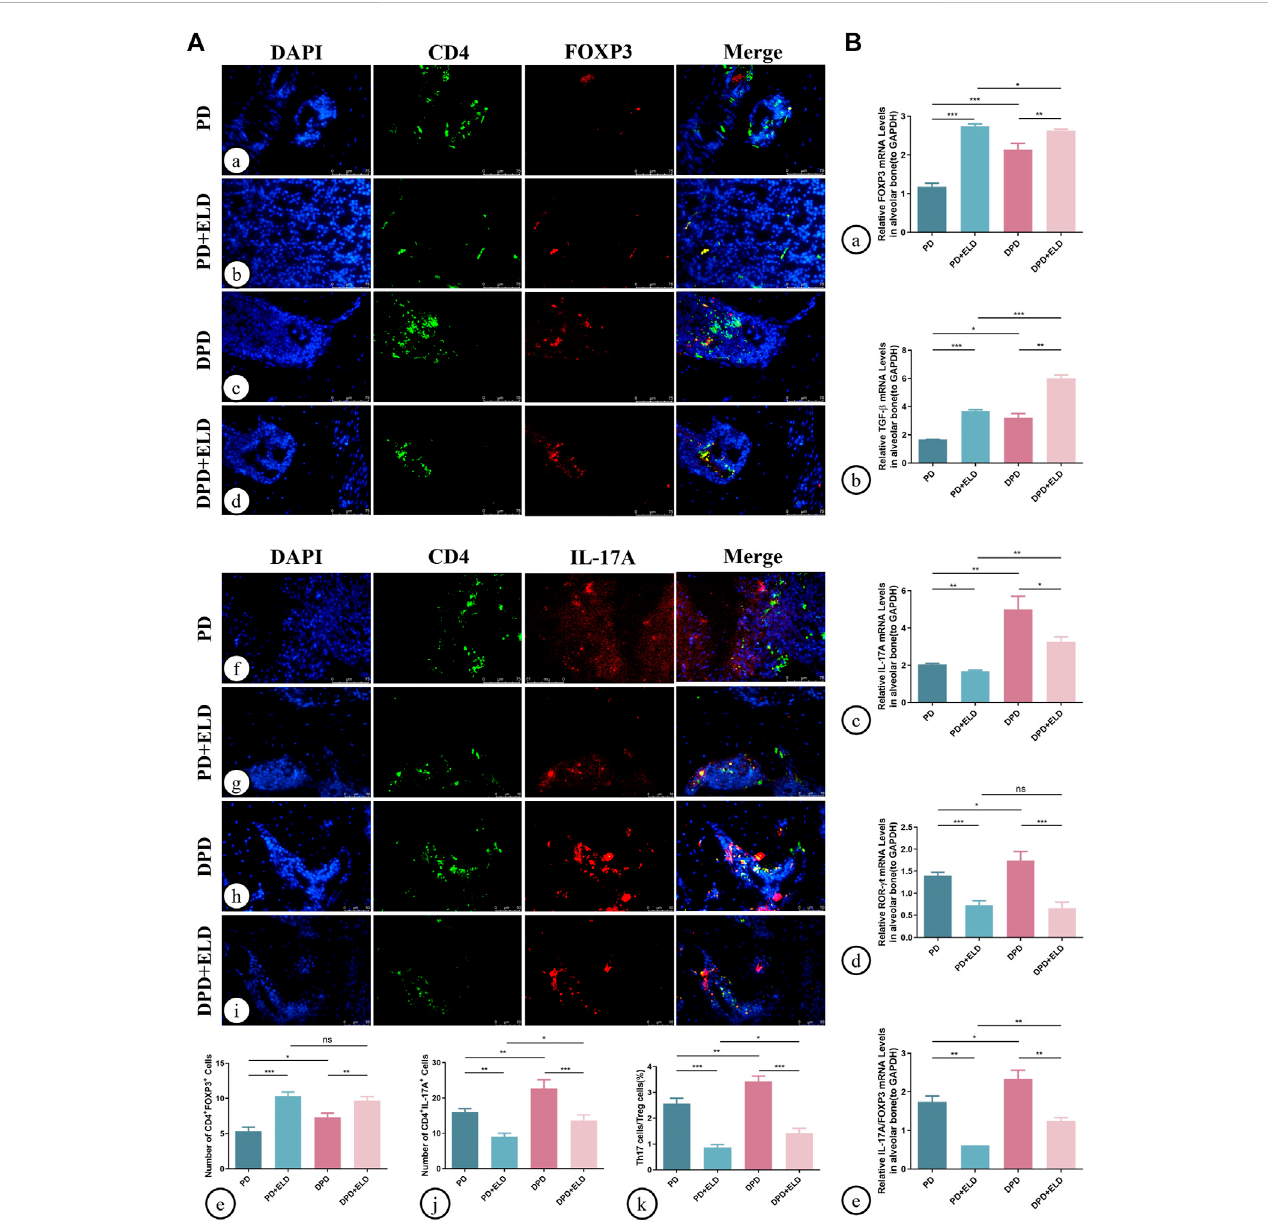
FIGURE 6 Immuno fl uorescence and qRT-PCR analysis of Th17 and Treg cells in the maxillary alveolar bone with ELD treatment. (A) The representative immuno fl uorescencestainingimagesofCD4 + FOXP3 + Tcellsinthe(a)PD,(b)PD+ELD,(c)DPDand(d)DPD+ELDgroups.(e)ThestatisticalanalysisofCD4 + FOXP3 + T cell counts. The representative immuno fl uorescence staining images of CD4 + IL-17A + T cells in the (f) PD, (g) PD + ELD, (h) DPD and (i) DPD + ELD groups.(j)ThestatisticalanalysisofthenumberofCD4 + IL-17A + Tcells.(k)TheratioofTh17/Tregcells. (B) RelativemRNAexpressionlevelsof (A) FOXP3, (b)TGF- β ,(c)IL-17A,(d)ROR- ɣ tand(e)theratioofIL-17A/FOXP3 inthePD,PD+ELD,DPDandDPD+ELDgroups.Datawereshownasmean±SD(* p < 0.05. ** p < 0.01. *** p <